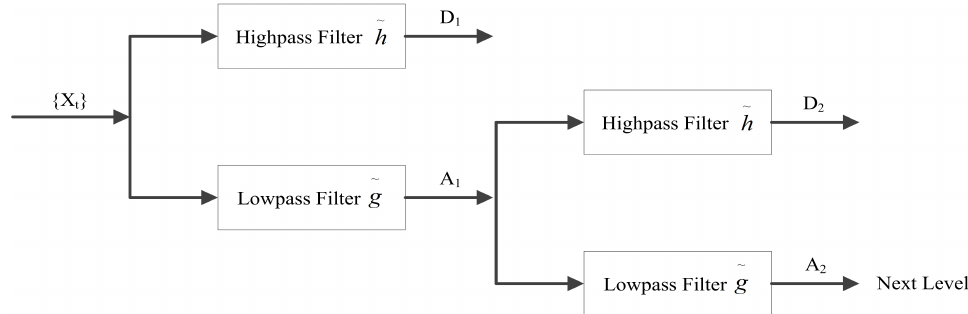
Figure 1. Process of MODWT